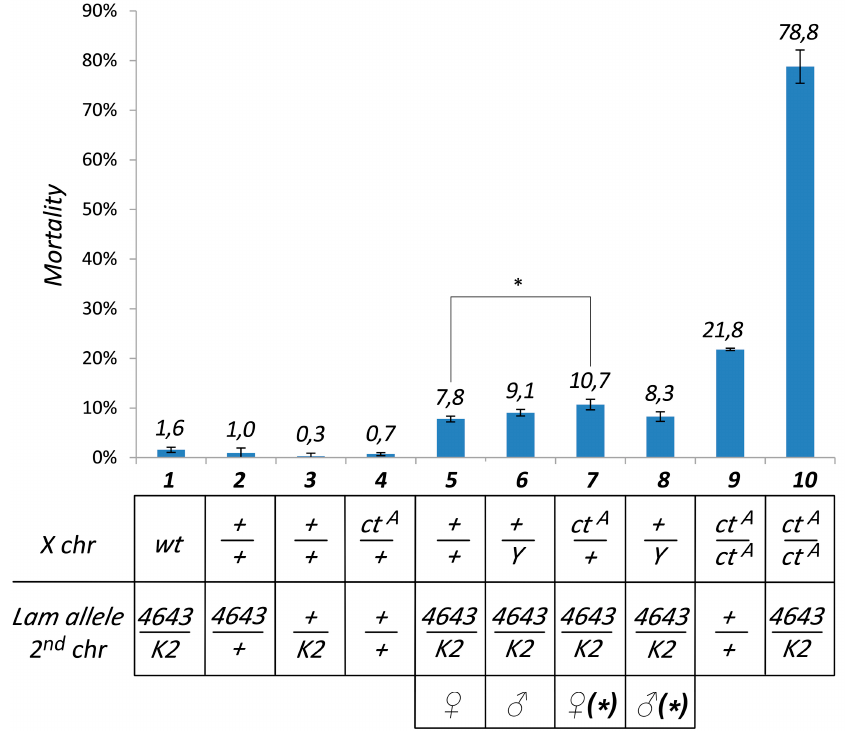
Figure 1. Mutation of the Lam gene induces mortality during adult eclosion, which is increased by a gypsy insertion in the euchromatic cut locus. Mortality during adult eclosion of pharate with di ff erent genotypes. Column 1: flies with X chromosomes from the wild type Canton S (wt) strain. Columns 2–10: flies with X chromosomes carrying the flamenco permissive allele flam A , which allows gypsy activation. These flies can have the gypsy induced mutation ( ct A ) in heterozygosis, in homozygosis / hemizygosis, or the wild type allele ( + ). Flies can be homozygous for the wild type Lam allele ( +/+ ), heterozygous for one of the two loss-of-function Lam alleles (4643 /+ or +/ K2) or transheterozygous (4643 / K2). Y: Y chromosome. Asterisk: females and males derived from the same genetic cross. Data are mean values from three independent experiments, and error bars indicate SD (* P <